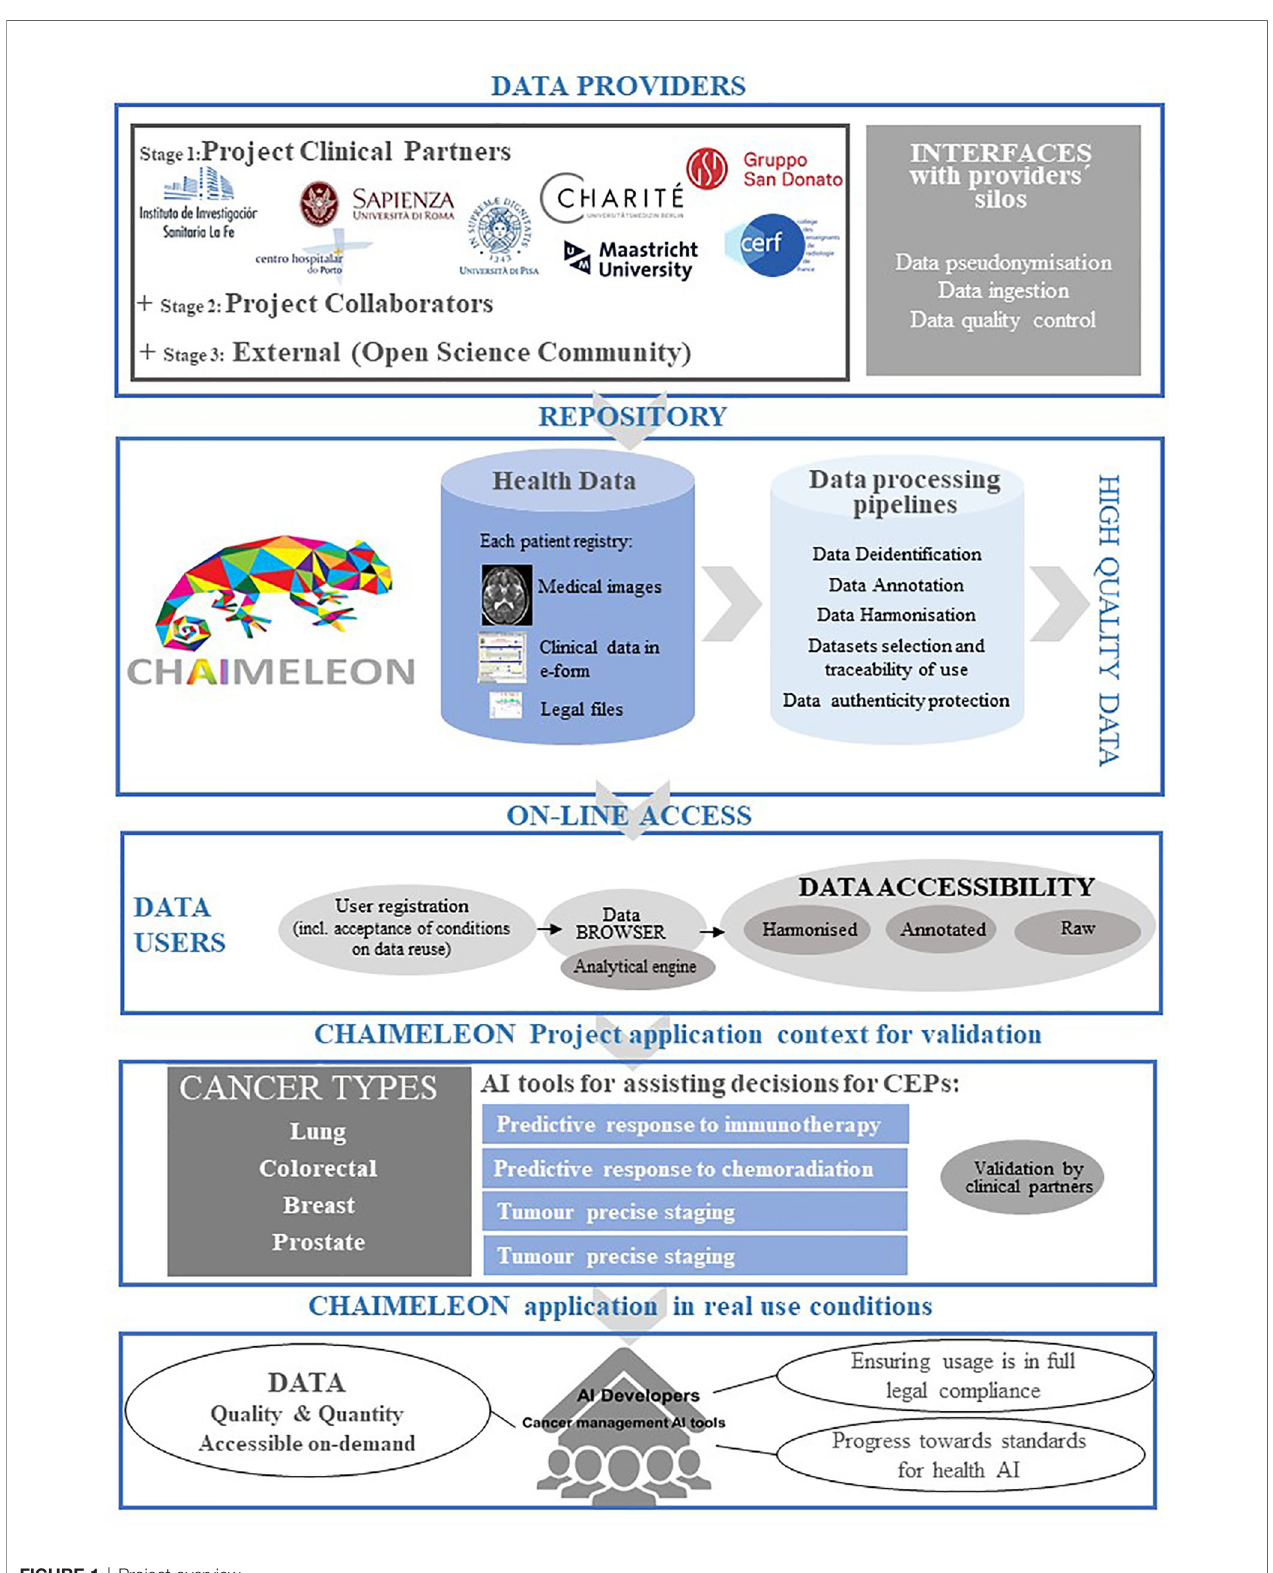
FIGURE 1 | Project